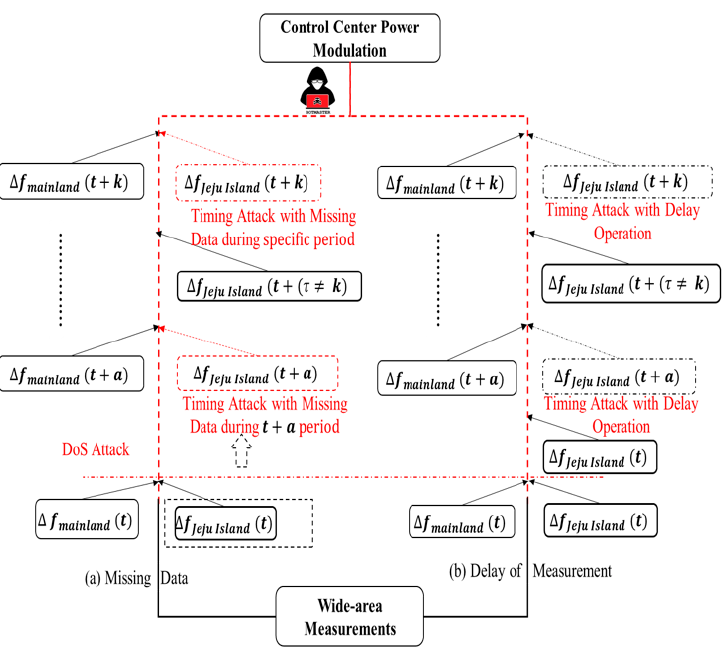
Figure 7. Illustration two types of DoS attack.